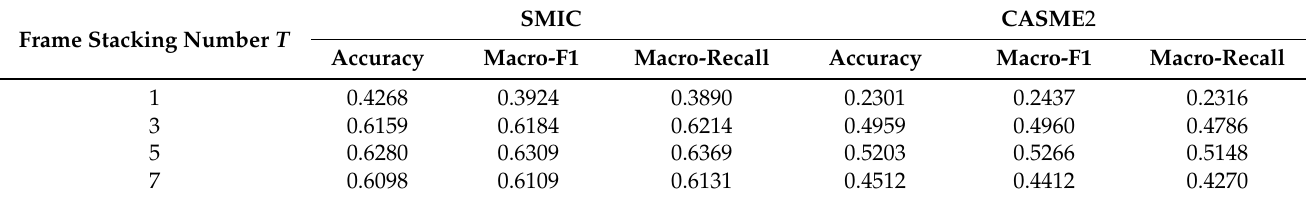
Table 3. ME recognition results of OF-PCANet+ with respect to different frame stacking number, T . Frame Stacking Number